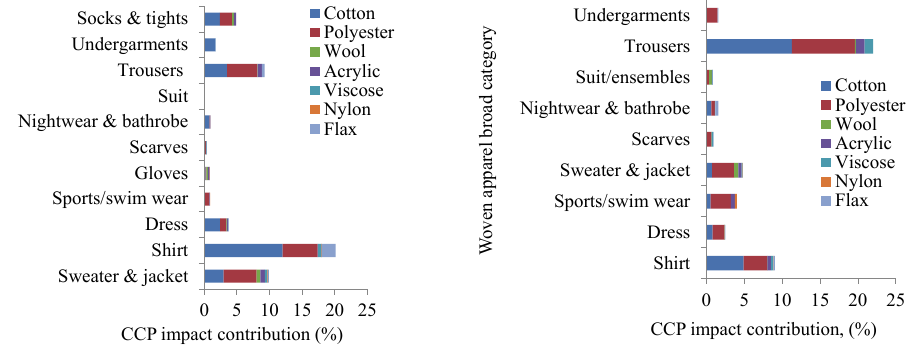
Fig. 12. CCP impact contribution of apparel broad categories based on total market